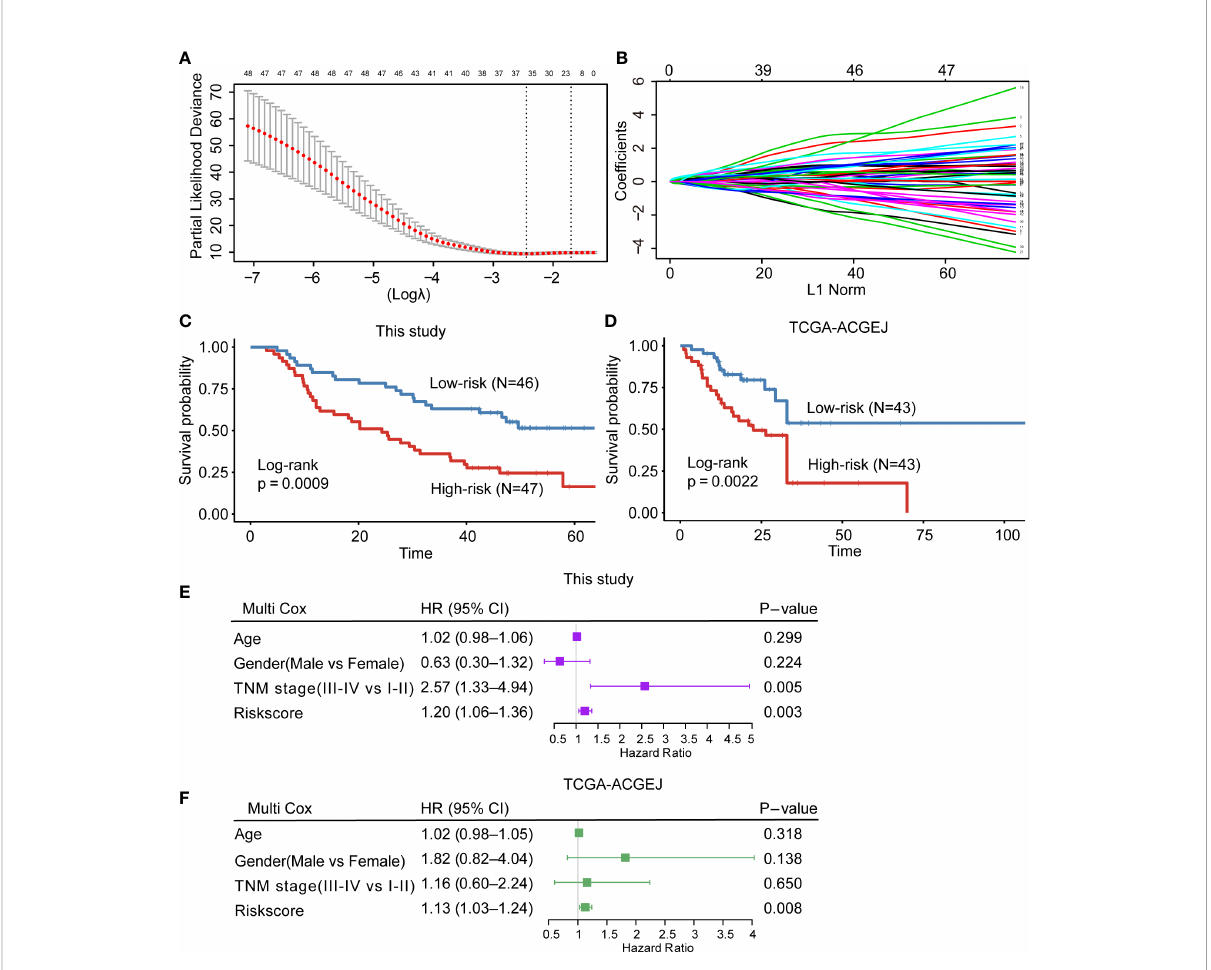
FIGURE 6 Construction and validation of the CD8+ T-cell in fi ltration-related prognostic prediction model. (A, B) LASSO Cox regression with 10-fold cross-validation to determine the prognostic value of 48 prognosis-related genes in the turquoise module. (C, D) Kaplan – Meier curve for the training cohort (C) and external validation cohort (D) . (E, F) Multivariate Cox regression analysis of clinicopathological factors and the risk score for our ACGEJ patients (E) and TCGA-ACGEJ patients (F)